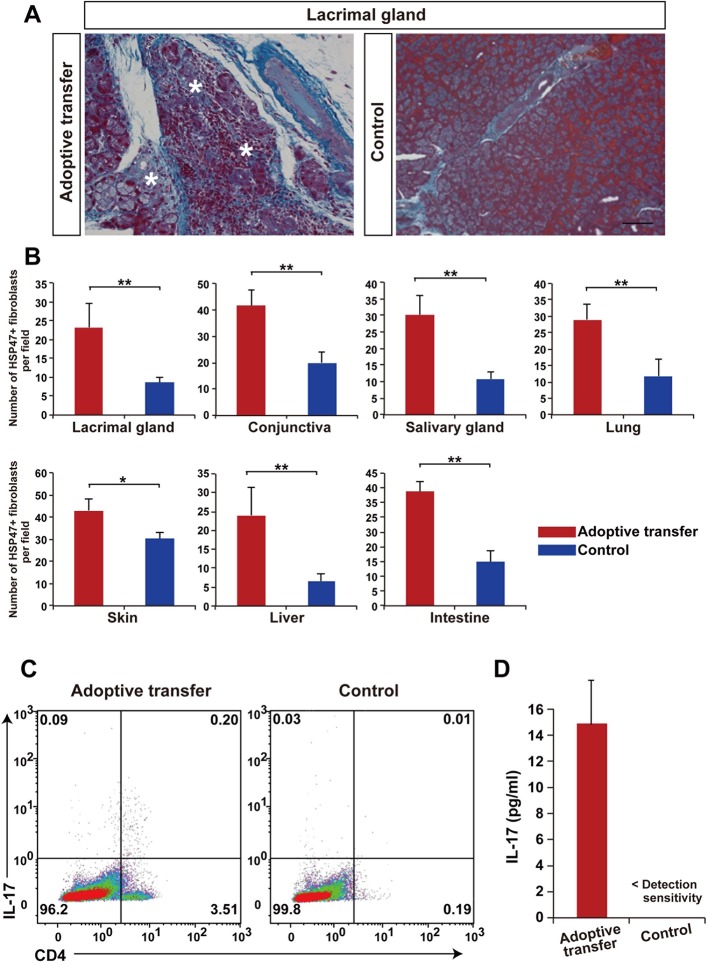
Adoptive transfer of recipient T cells from mismatched BMSC- transplanted recipients into BALB/c background Nude mice induce disease.(A) Adoptive transfer of BALB/c T cells from mismatched BMSC-transplanted mice induced excessive fibrosis accompanied by numerous inflammatory cells in the lacrimal gland of naive nude mice, as shown by Mallory staining (excessive fibrotic area in deep blue [*]). Scale bar, 100 μm. Data collected from two replicate experiments (n = 4 per group). (B) The number of HSP47+ fibroblasts was significantly higher in various target organs following adoptive transfer of BALB/c T cells from mismatched BMSC recipients into nude mice (red), compared to wild-type (WT) nude mice (blue). Data are shown as mean ± SD. *p<0.005, **p<0.001. (C) CD4+ Th 17+ splenic cells were markedly elevated from adoptively transferred nude mice (left), compared to WT BALB/c background nude mice (right) (n = 4 each). (D) 1L-17 concentration in the serum from the same mice of the experiments shown in Figure 4C (n = 4 each). Data from one of two independent experiments (A,D). BMSC, bone marrow stromal/stem cells; HSP, heat-shock protein.DOI:
http://dx.doi.org/10.7554/eLife.09394.02010.7554/eLife.09394.021Figure 5—source data 1.Number of HSP47+ cells in various target organs following adoptive transfer of BALB/c T cells from mismatched BMSC recipients into nude mice.Data from the lacrimal gland, conjunctiva, salivary gland, lung, skin, liver, and intestine as shown in (B). BMSC, bone marrow stromal/stem cells; HSP, heat-shock protein.DOI:
http://dx.doi.org/10.7554/eLife.09394.02110.7554/eLife.09394.022Figure 5—source data 2.1L-17 concentration in the serum from adoptively transferred nude mice, compared to WT BALB/c background nude mice.Source data for graph in (D). WT, wild type.